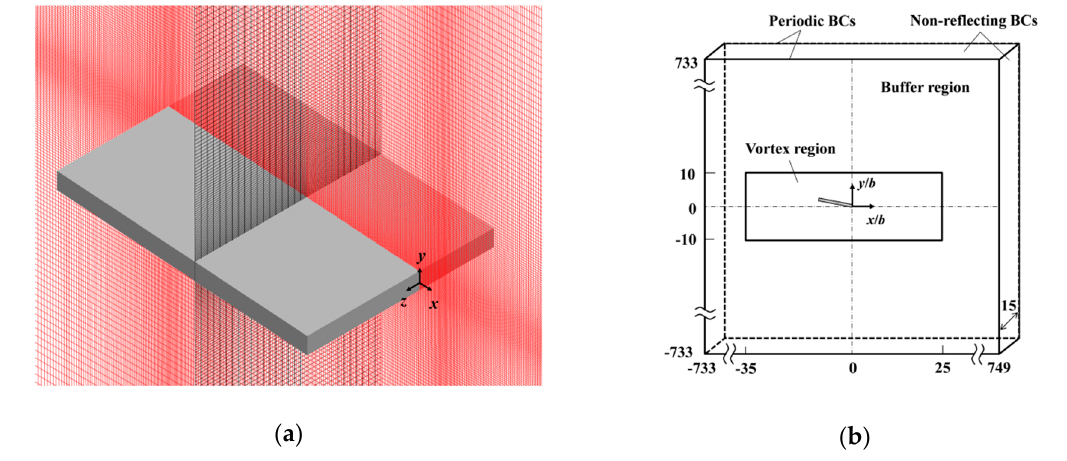
Figure 8. Computational grid and domain of flow around an oscillating plate. ( a ) Computational grid; ( b ) Computational domain and boundary conditions.